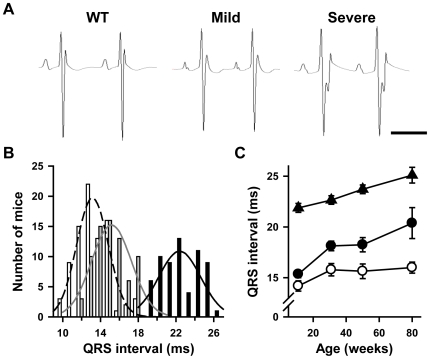
Variable degrees of ventricular conduction defects in Scn5a
+/− mice.
A. Representative lead I ECGs from 10 week-old wild-type (WT) mice and Scn5a
+/− mice with mild and severe conduction defects. Scale bar, 100 ms. B. Distribution of QRS interval duration with corresponding Gaussian fits in 10 week-old WT mice (white bars) and Scn5a
+/− mice with mild (grey bars) and severe (black bars) phenotype. C. Effects of age (X-axis) on QRS interval duration (Y-axis) in WT mice (open symbols) and Scn5a
+/− mice with mild (filled circles) and severe (filled triangles) phenotype. See Table 1 for statistics.